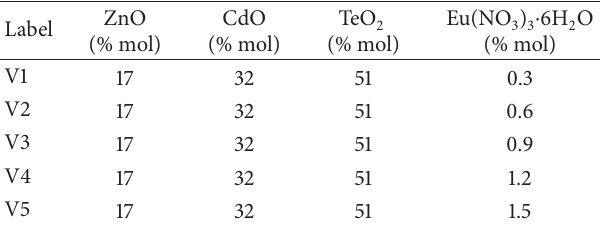
:Eu glasses deter- 2